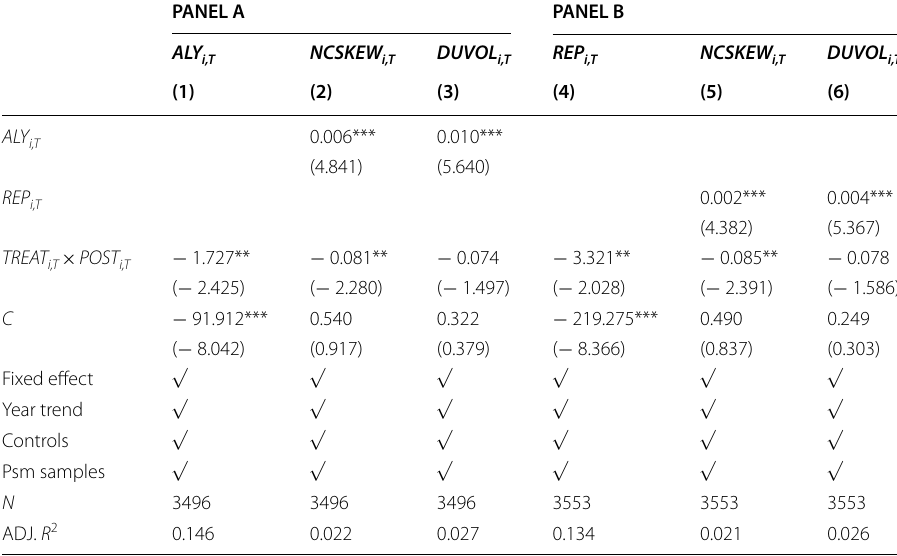
Table 16 Analyst coverage mechanism